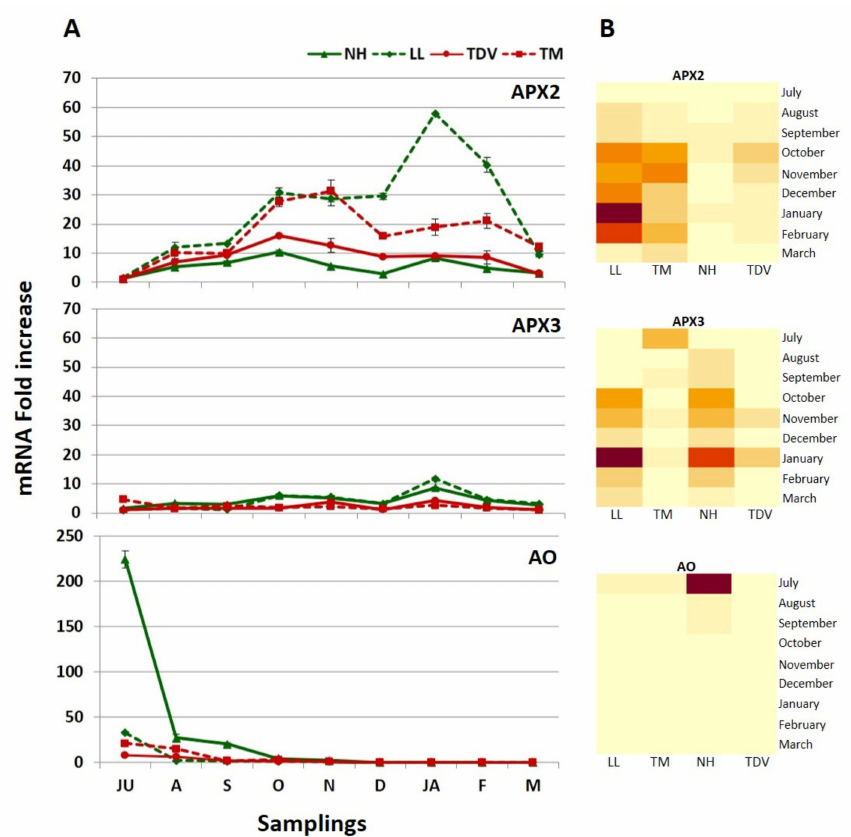
Figure 11. Real-time expression data ( A ) and heatmap ( B ) of the APX2 , APX3 , and AO genes involved in the degradation pathway in the juice of Lanelate (LL), Tarocco Meli (TM), Newhall (NH), and Tarocco TDV (TDV) genotypes from July to March. The data are the mean ± S.E. of at least three replicates. In the heatmap, gene expression decreases according to the colour scale, from rust red to creamy